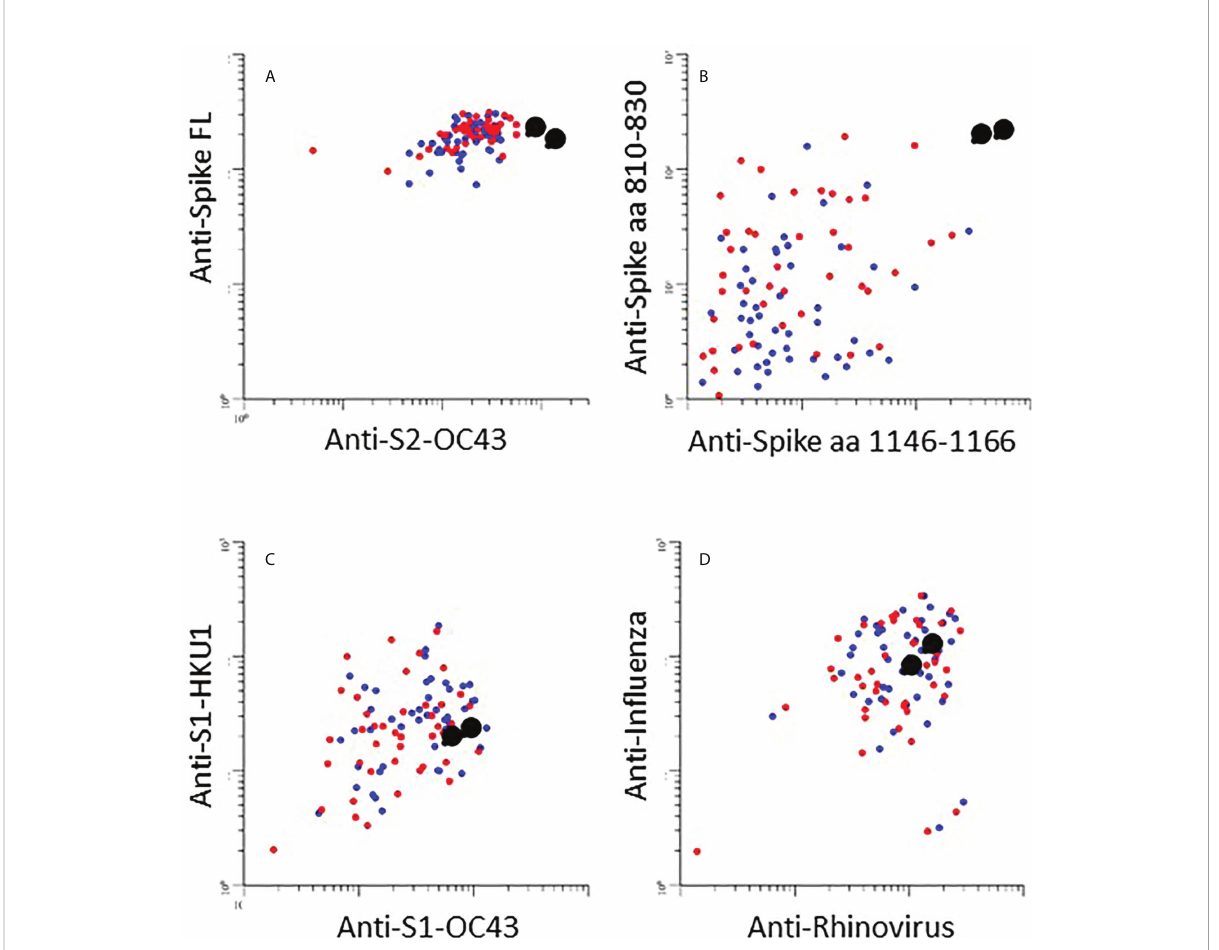
FIGURE 5 (A – D) : The scatter plots show relative levels of IgG antibodies to indicated antigen in individuals infected with Omicron. Enlarged black dots correspond to unvaccinated individual (see Fig. 4). (A) : IgG responses against spike-full length protein (Spike FL) from the SARS-CoV-2 Wuhan strain (y-axis) and the S2 domain of seasonal coronavirus OC43 (S2-OC43) (x-axis). (B) : IgG responses against Spike aa 810-830 (y-axis) and aa 1146-1166 (x-axis): linear peptide antigens that are conserved in the S2 domains of spike proteins in SARS-CoV-2 and seasonal coronaviruses OC43 and HKU1(15)]. (C) : IgG responses against the S1 domains from seasonal coronaviruses HKU1 and OC43, respectively (S1 HKU1/OC43). (D) : IgG responses against in fl uenza (y-axis) and rhinovirus